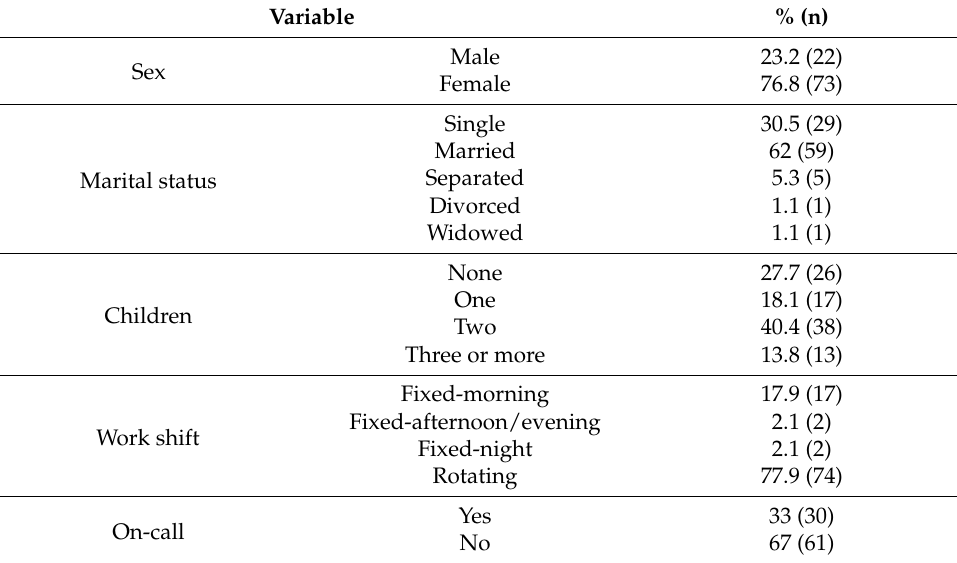
Table 1. Descriptive data and qualitative variables.